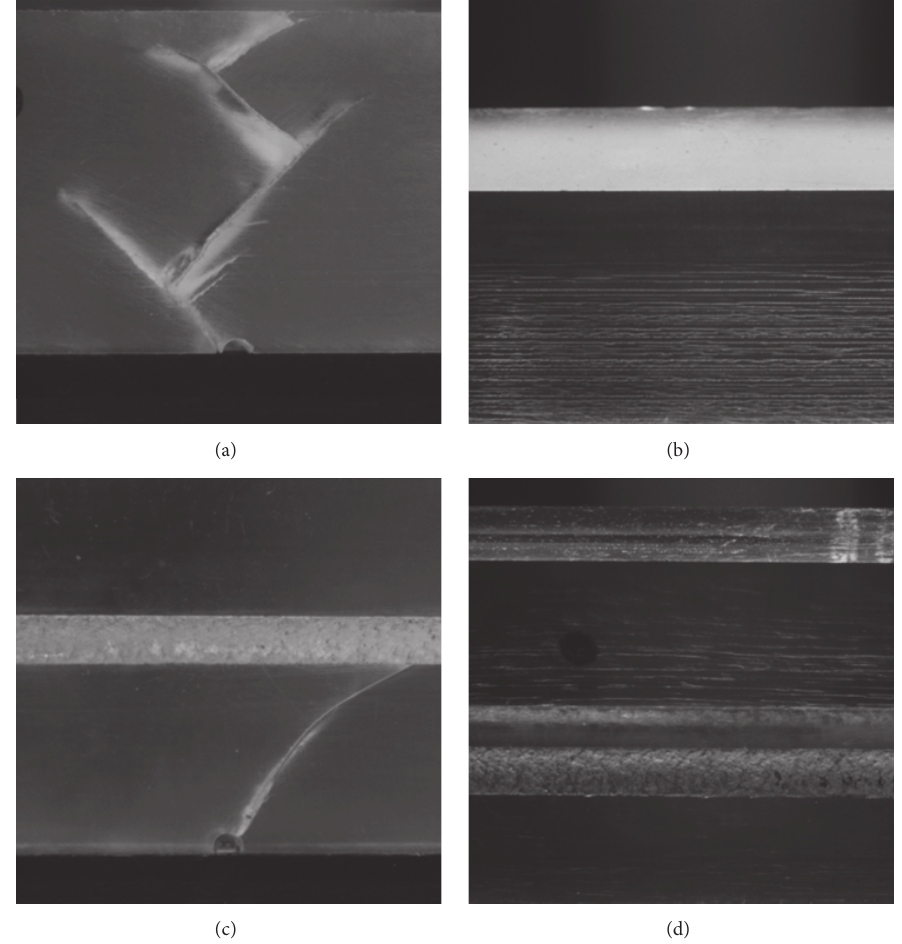
Figure 10: Damage images of monolayer and laminated directional PMMA. (a) Crack propagation of monolayer directional PMMA; (b) surface microcracks of monolayer directional PMMA; (c) crack propagation of laminated directional PMMA; (d) surface microcracks of laminated directional